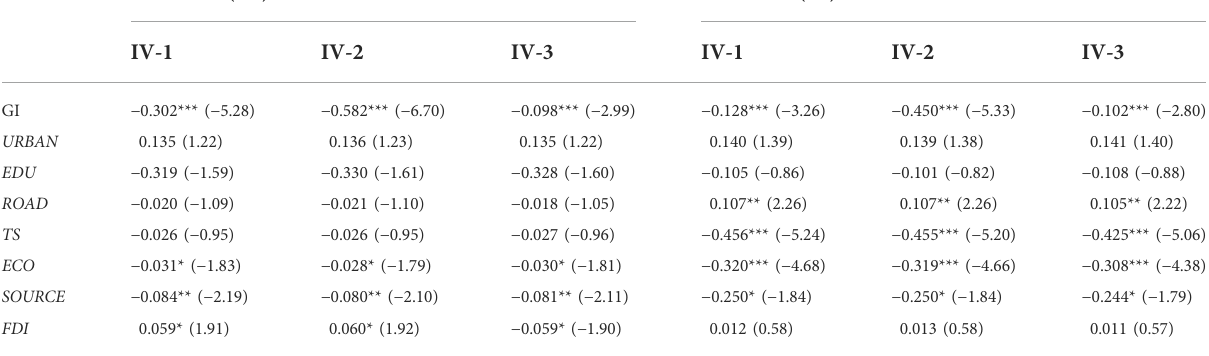
TABLE 7 Estimation results of instrumental variable